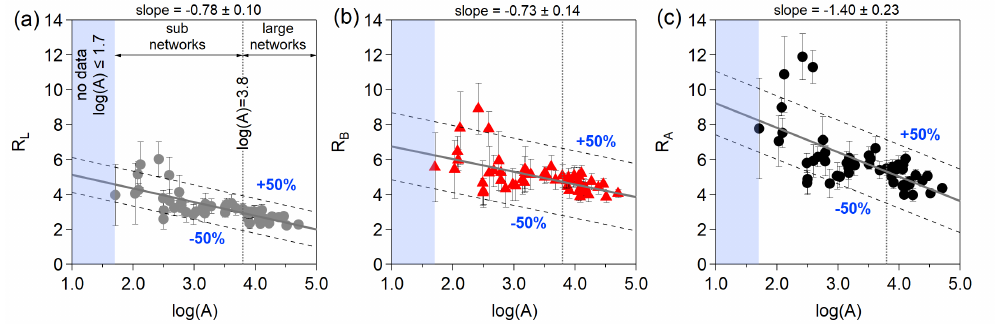
Figure 5. Comparison between ( a ) R L , ( b ) R B and ( c ) R A versus log ( A ) . Error bands ∆ L , ∆ B and ∆ A were included for each plot. The overall slope of each linear fit is η = − 0.78 ± 0.10, − 0.73 ± 0.14 and − 1.40 ± 0.23 for R ± 50% scattering band was traced around L , R B and R B , respectively. An arbitrary each